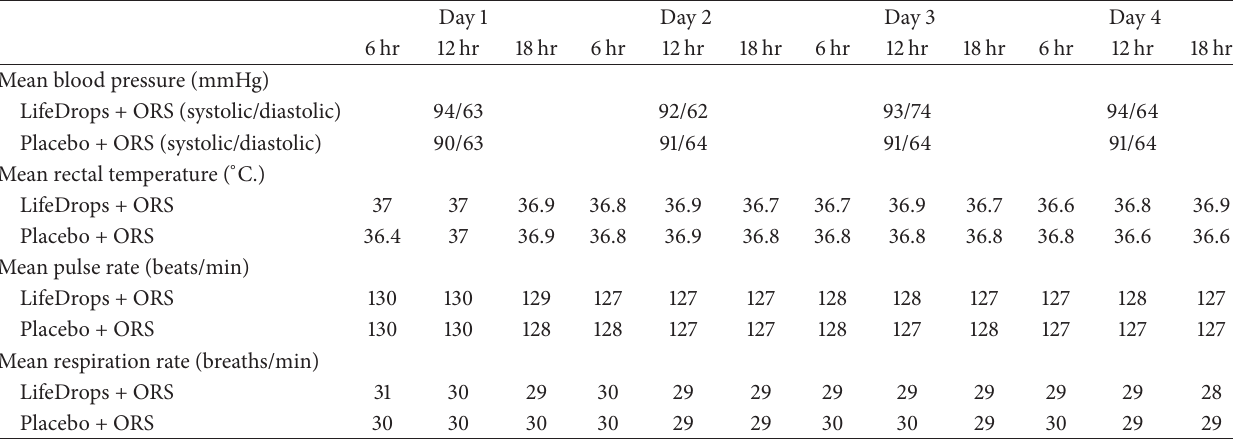
Table 4: Mean blood pressures, rectal temperatures, pulse rates, and respiration rates over 4 days of subjects 6 to 23 months old consuming either LifeDrops solution in ORS or water (as a placebo) in ORS. Measurements were taken three times each day.